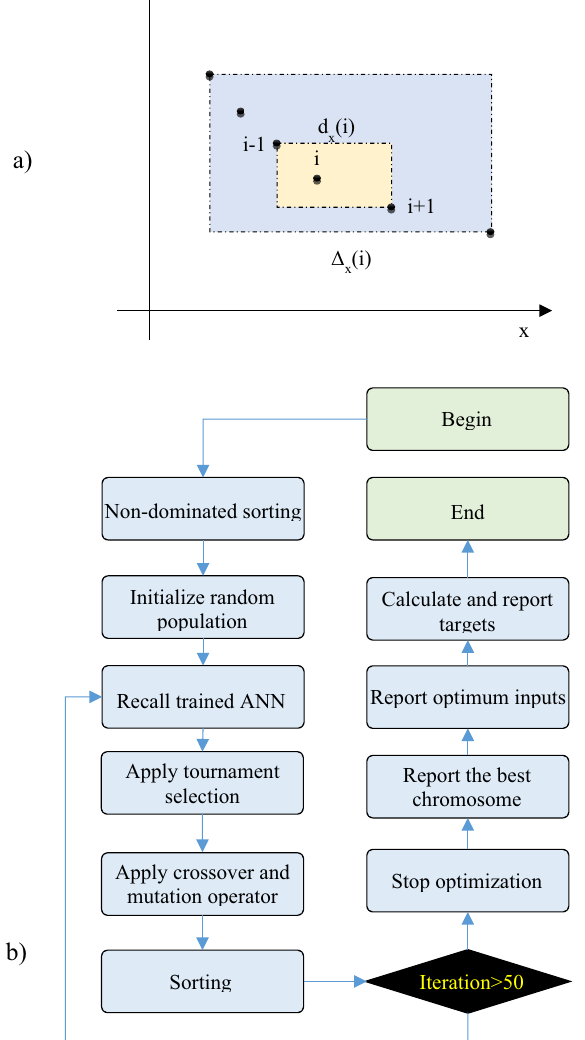
Figure 4. ( a ) Crowding distance calculation parameters for sample i, and ( b ) flowchart of NSGA-II based